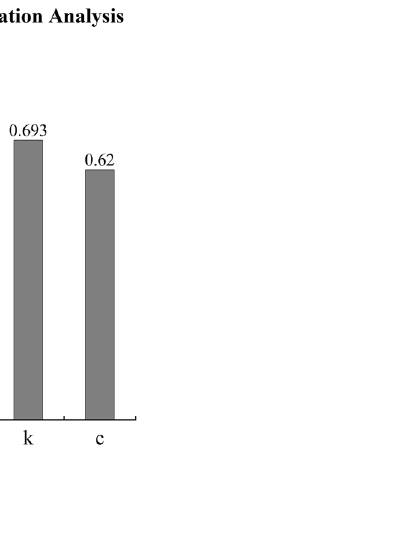
Figure 1. Grey relation analysis